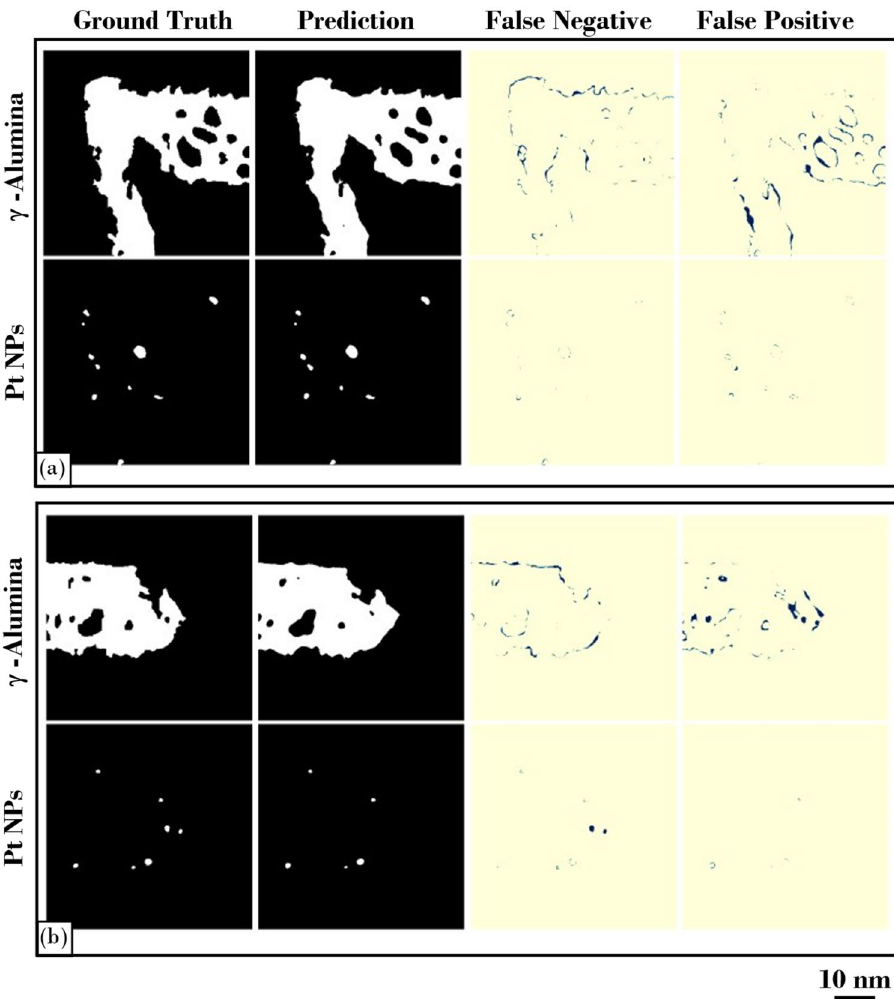
Figure 3. A set of ground truth and predicted segmentations of γ-Alumina and Pt NPs from the validation data and corresponding false negative and false positive maps show the discrepancies in the overlap of each class. The images in ( a ) and ( b ) represent two 512 × 512 pixels size patches from the validation data set; for illustrative purpose, each set of images demarcated with a black frame. Upper rows are segmentation results from the γ-Alumina particle and lower rows are from the Pt NPs of the same patch.